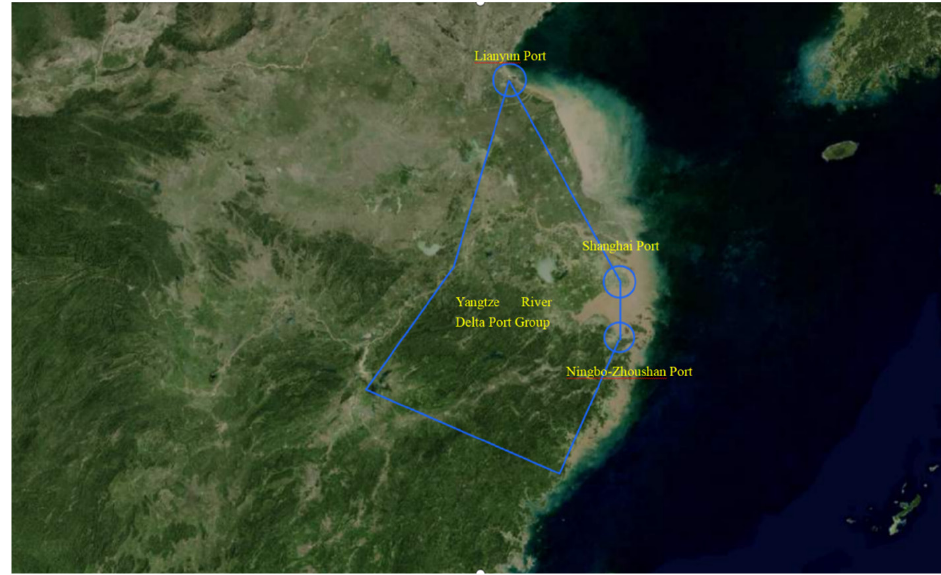
Figure 1. The map of Yangtze River Delta port group.